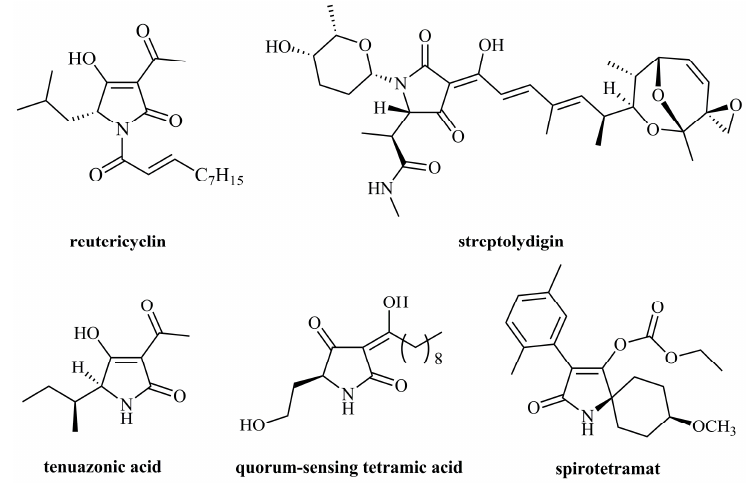
Figure 1. Examples of antimicrobial natural products incorporating the tetramic acid ring and the agricultural commercial available product spirotetramat.